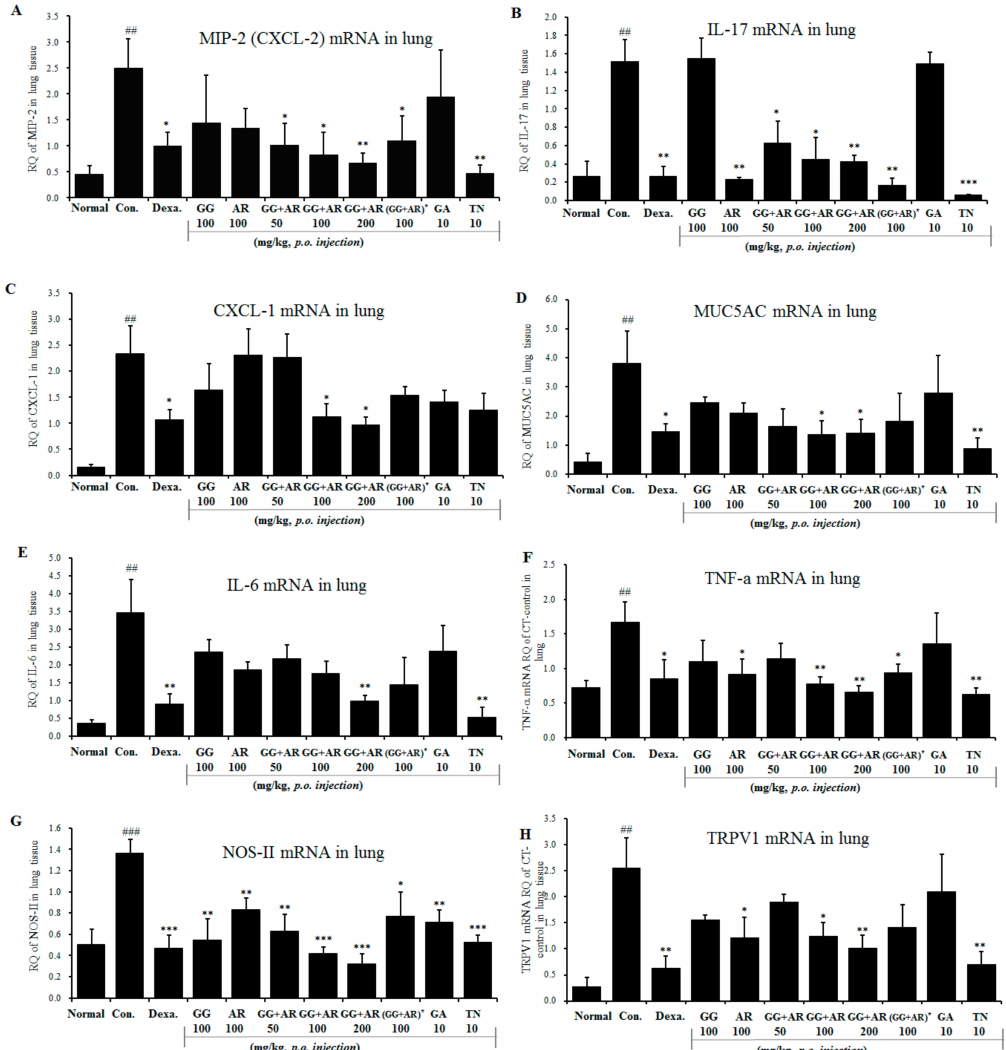
Figure 5. E ff ects of GG, AR, GG plus AR, GA, and TN on CXCL2, IL-17A, CXCL1, MUC5AC, IL-6, TNF- α NOS-II, and TRPV1 mRNA gene expression in the lung tissue of CFD-induced COPD model mice. CXCL2 ( A ), IL-17A ( B ), CXCL1 ( C ), MUC5AC ( D ), IL-6 ( E ), TNF- α ( F ), NOS-II ( G ), and TRPV1 ( H ) mRNA levels were measured in mouse lung tissue of each groups. Normal: normal group; Con.: CFD, CFD-induced COPD model group; Dexa.: CFD solution and administrated with dexamethasone 3 mg / kg group; GG 100: CFD solution and administrated with GG extract 100 mg / kg group; AR 100: CFD solution and administrated with AR extract 100 mg / kg group; GG + AR 50: CFD solution and administrated with GG plus AR extract 50 mg / kg group; GG + AR 100: CFD solution and administrated with GG plus AR extract 100 mg / kg group; GG + AR 200: CFD solution and administrated with GG plus AR extract 200 mg / kg group; GG + AR 100* (trial product): CFD solution and administrated with GG plus AR (trial product) 100 mg / kg group; GA 10: CFD solution and administrated with GA 10 mg / kg group; TN 10: CFD solution and administrated with TN 10 mg / kg group. The statistical significance of di ff erences between control and treatment groups were assessed by ANOVA and Duncan’s multiple comparison test. Data represent the mean ± SEM of 8 independent experiments. (## P < 0.01, ### P < 0.001, significantly di ff erent from the value of normal group. * P < 0.05, ** P < 0.01, and *** P < 0.001 significantly di ff erent from the value of control